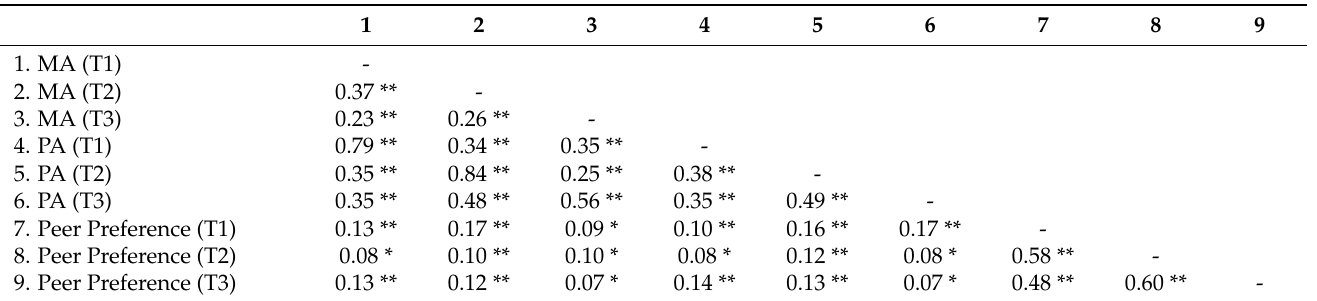
Table 2. Inter-correlations among study